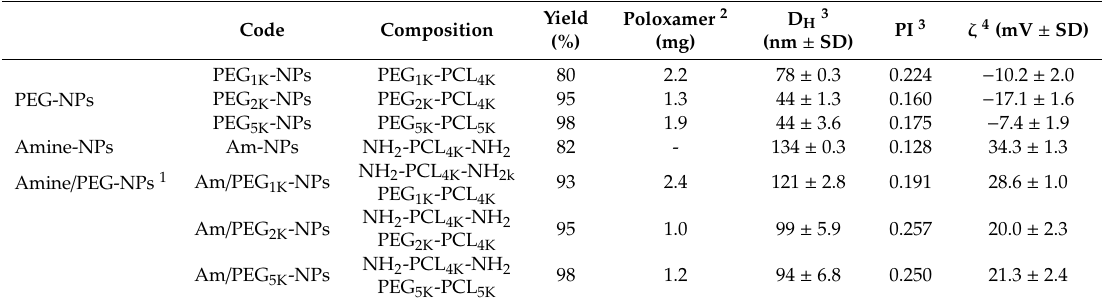
Table 1. Colloidal properties of NPs. Values are expressed as mean ± SD of three di ff erent batches.